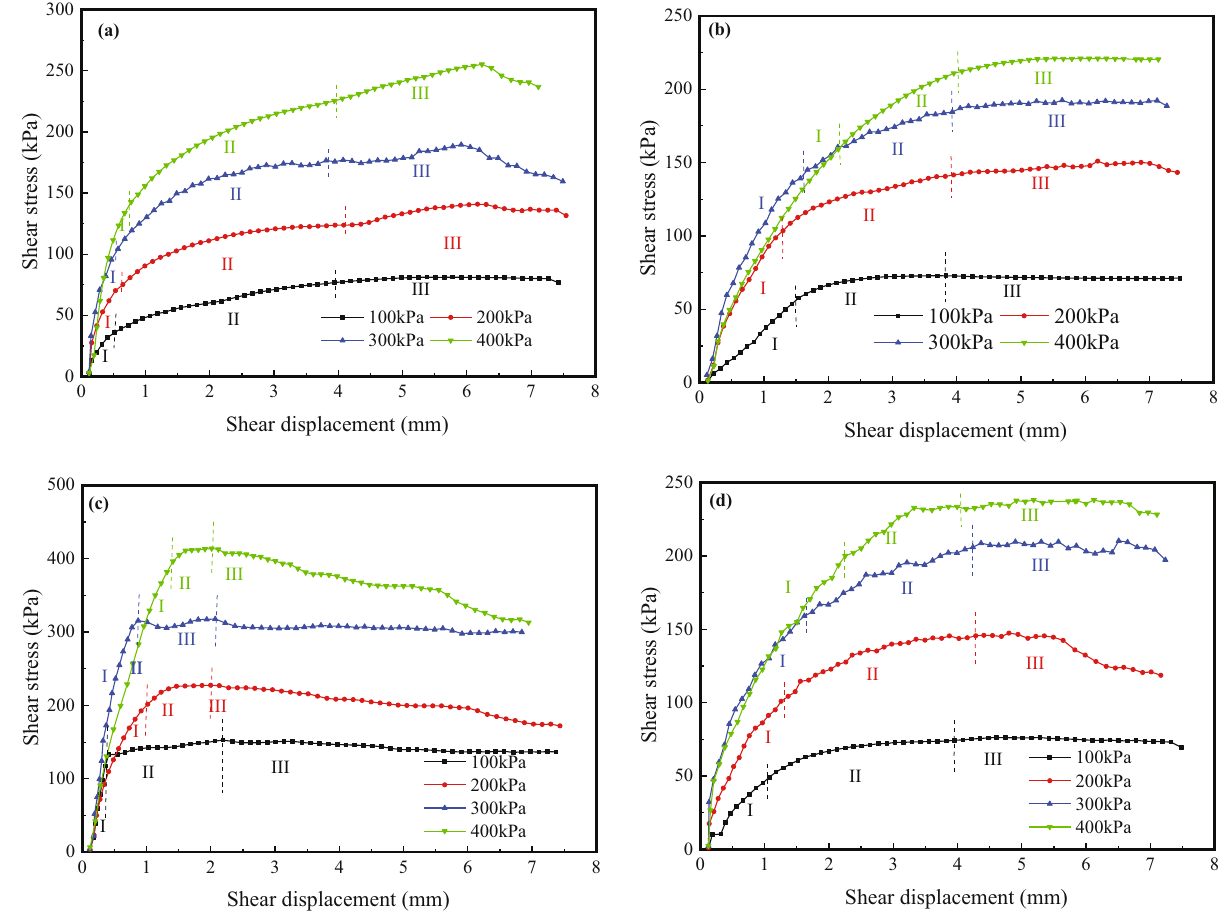
Figure 16: Shear stress – shear displacement curves of improved specimens of di ff erent materials: ( a ) straw; ( b ) starch; ( c ) cement; and ( d ) epoxy